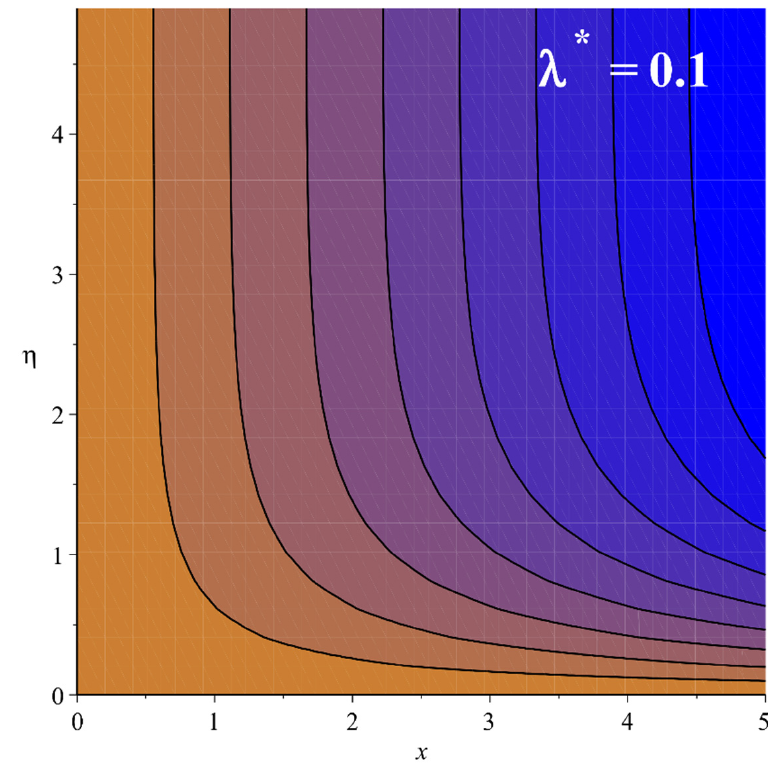
Figure 14. Stream lines when λ ∗ = 0.1.